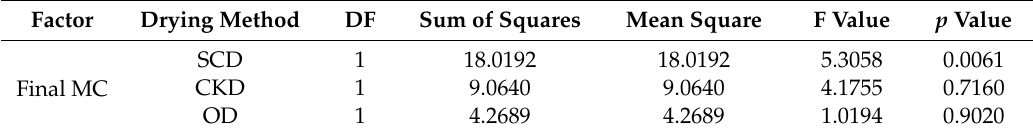
Figure 6. Moisture distribution of specimens under different drying conditions. Table 5. Final MC of three drying methods analysis of variance with moisture distribution.